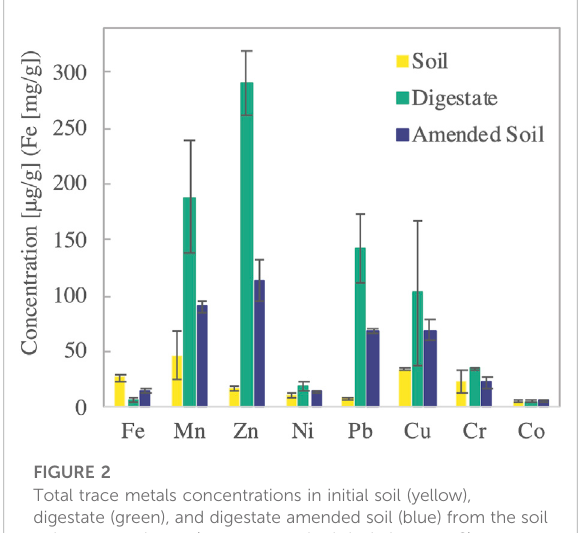
FIGURE 2 Total trace metals concentrations in initial soil (yellow), digestate (green), and digestate amended soil (blue) from the soil column experiment (mean ± standard deviation, n =